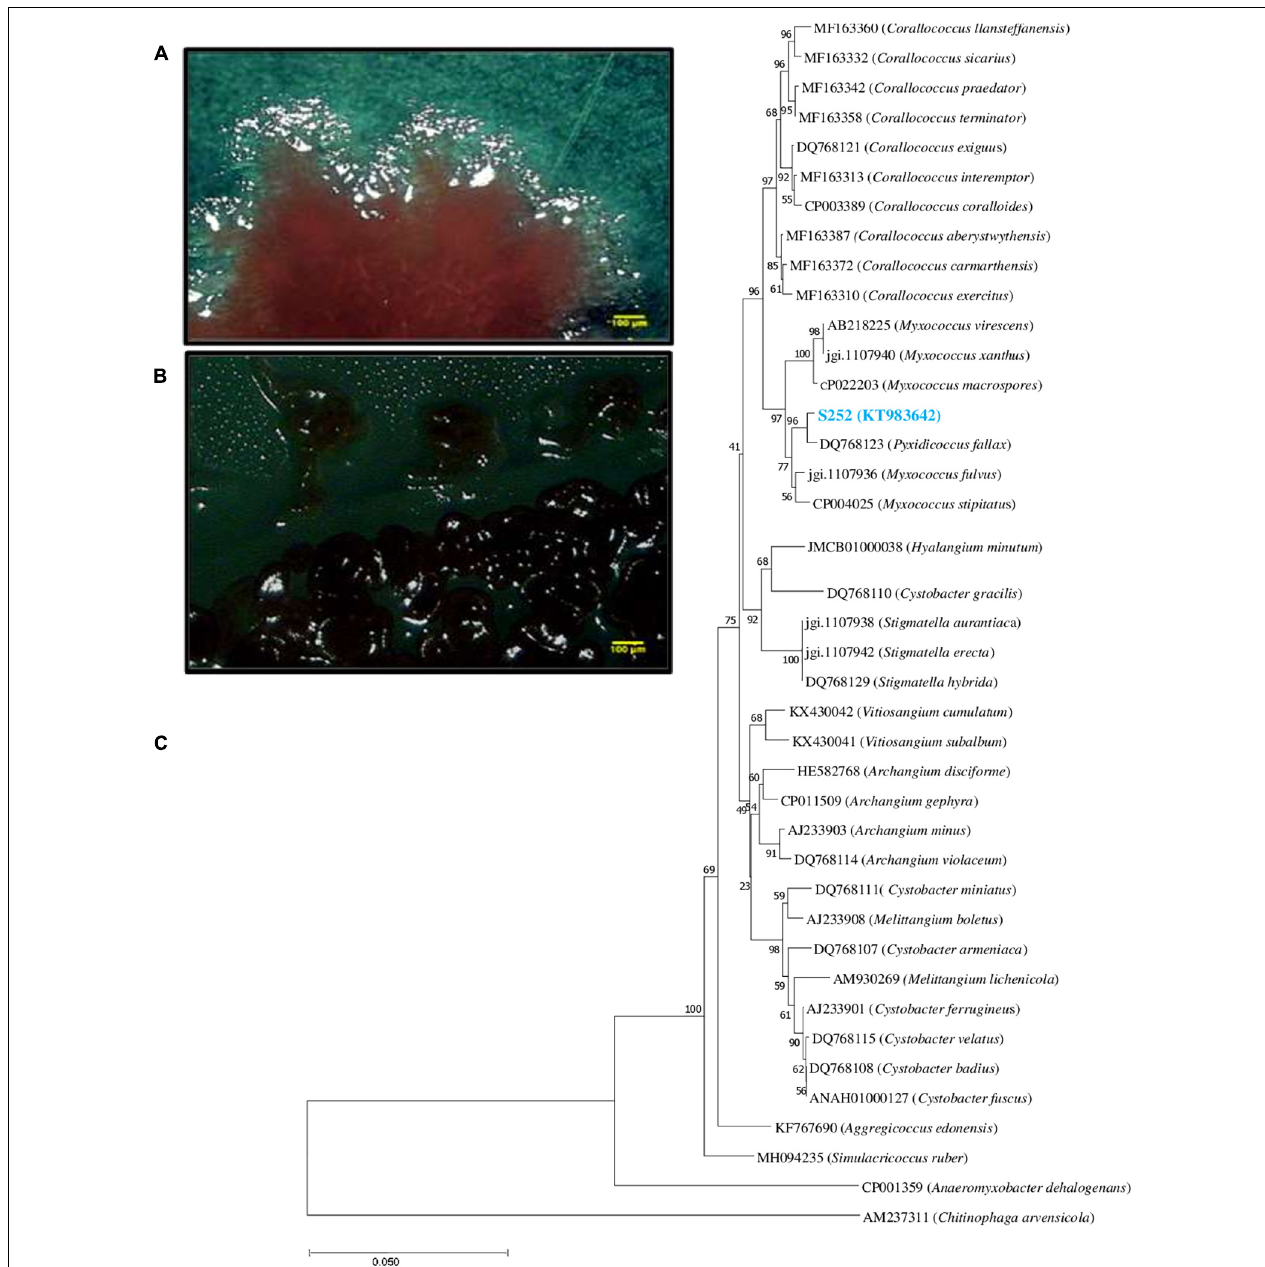
FIGURE 1 | (A) Swarm morphology (B) fruiting bodies of strain S252 under stereomicroscope. (C) Phylogenetic tree based on 16S rDNA gene sequence of Pyxidicoccus sp. S252 (blue color text) constructed using neighbor-joining method aligned with the closest type strains.